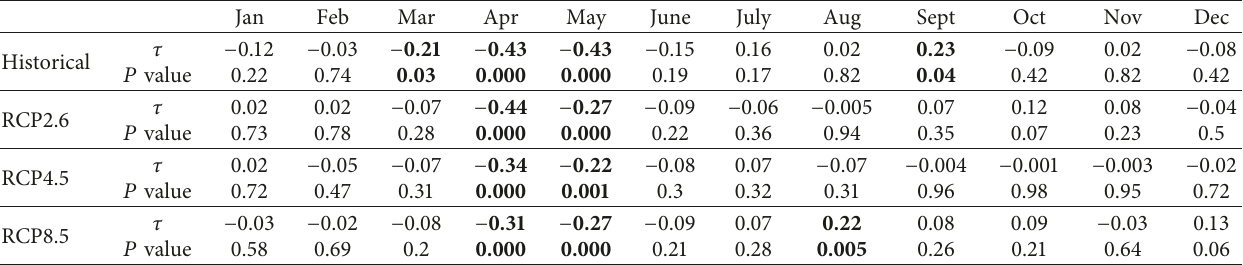
Table 7: Kendall correlation coefficient ( τ ) and P value for mean temperature and precipitation in historical and future periods. Jan Feb Mar Apr May June July Aug Sept Oct Nov Dec